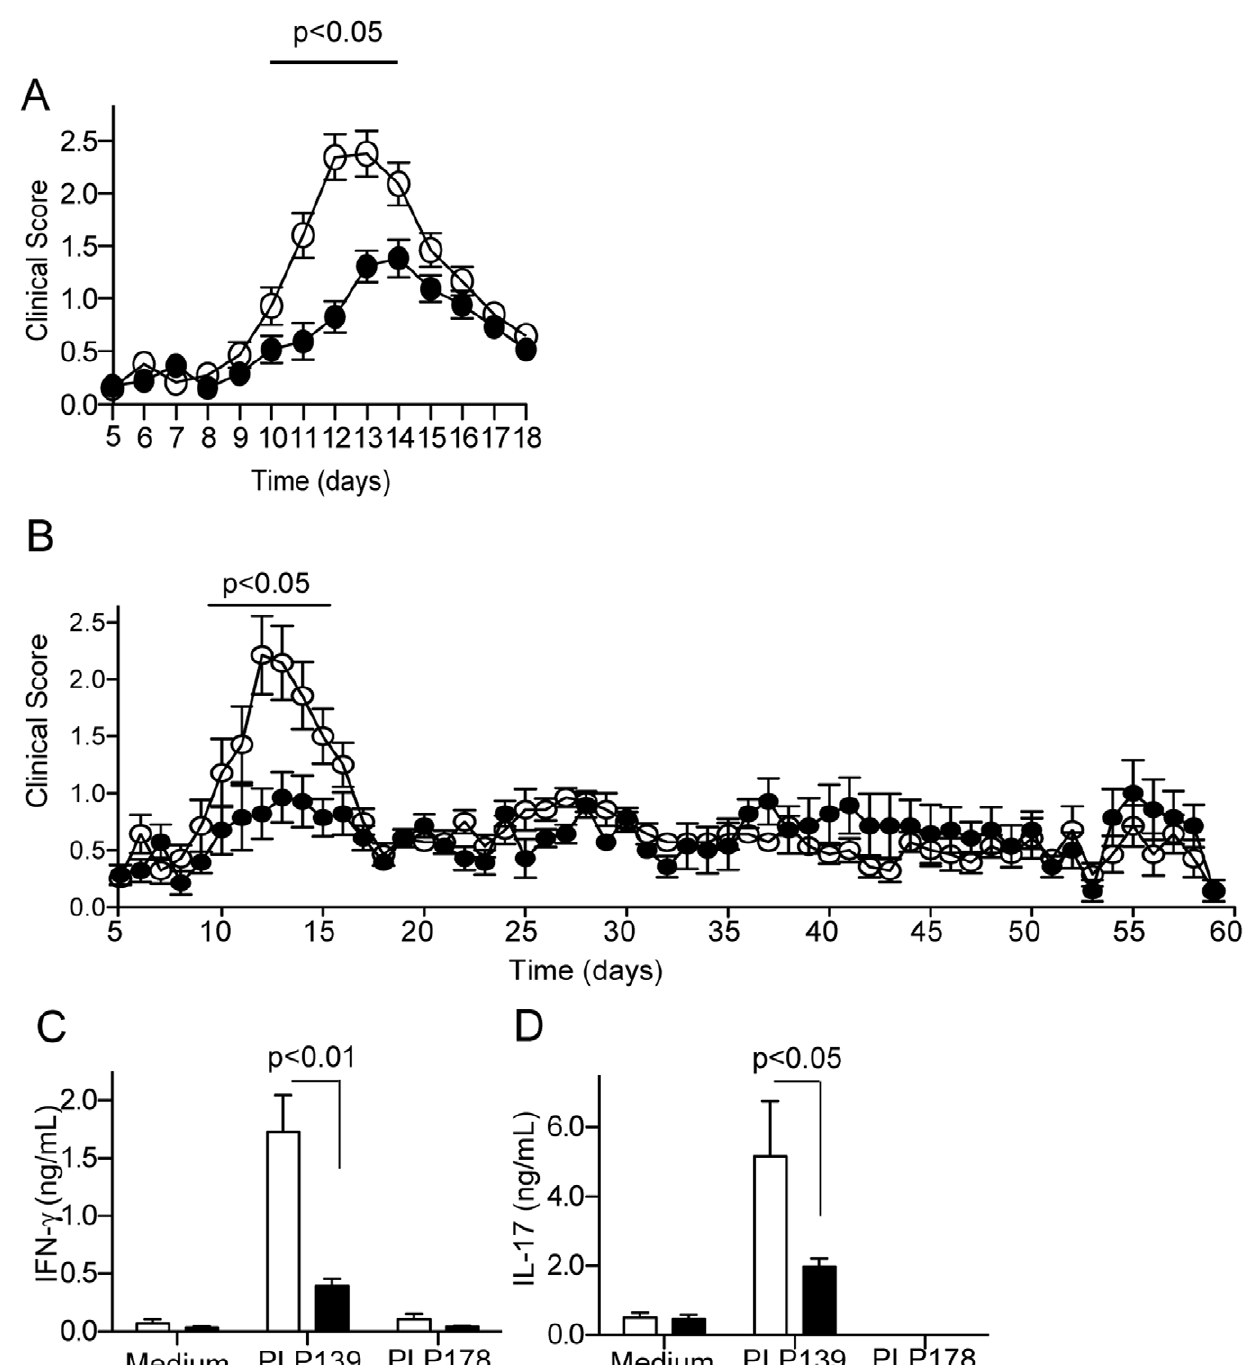
Figure 3. TLR7 ligand treatment reduced clinical severity, and T cell responses of EAE mice. (A) SJL/J mice were i.p. immunized with PLP 139–151 in CFA with Ptx. Mice (n=26/group) received 150 nmol/animal 1V136 or vehicle s.c. daily from day 6 onward. The mice were scored for disease and the data were pooled from four independent experiments. Bar indicates p , 0.05 by two-way ANOVA with Bonferroni post hoc tests. (B) SJL mice were immunized as above (n=14/group) and treated from day 5 to 18 with 150 nmol/animal 1V136 or vehicle s.c. and disease was monitored up to 60 days. Data are pooled from 2 independent experiments and the bar indicates p , 0.05 by two-way ANOVA with Bonferroni post hoc tests. (C, D) Splenocytes obtained from vehicle- (n=5) and 1V136-treated (n=5) SJL/J EAE mice at 19 days were restimulated in vitro with PLP